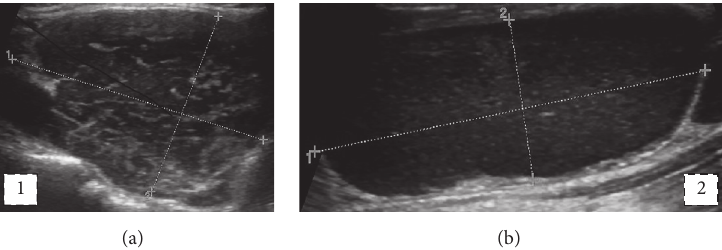
Figure 1: (a) Thyroid nodule, large (29 × 44 × 31mm transverse, longitudinal, and anteroposterior diameters, resp.) hypoechogenic hetero- geneous thyroid nodule with regular borders; (b) lymph node, large (48 × 20 mm), hypoechoic, partly cystic lymph